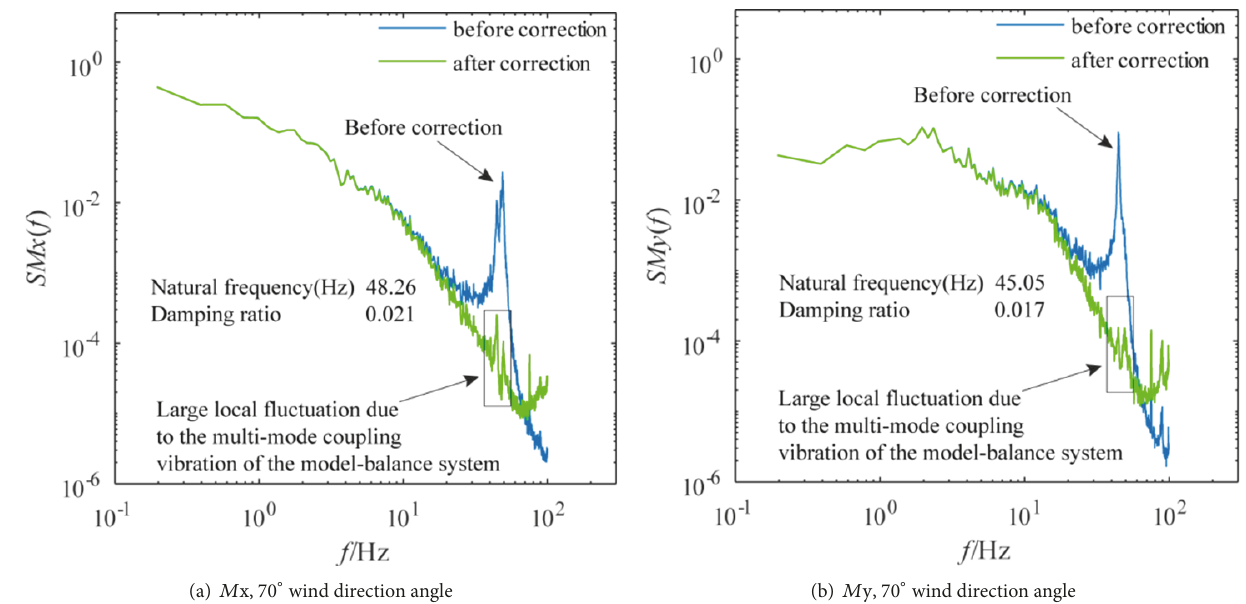
Figure 8: The identified dynamic parameters of the model-balance system of Guangzhou East Tower under different wind directions after decoupling.